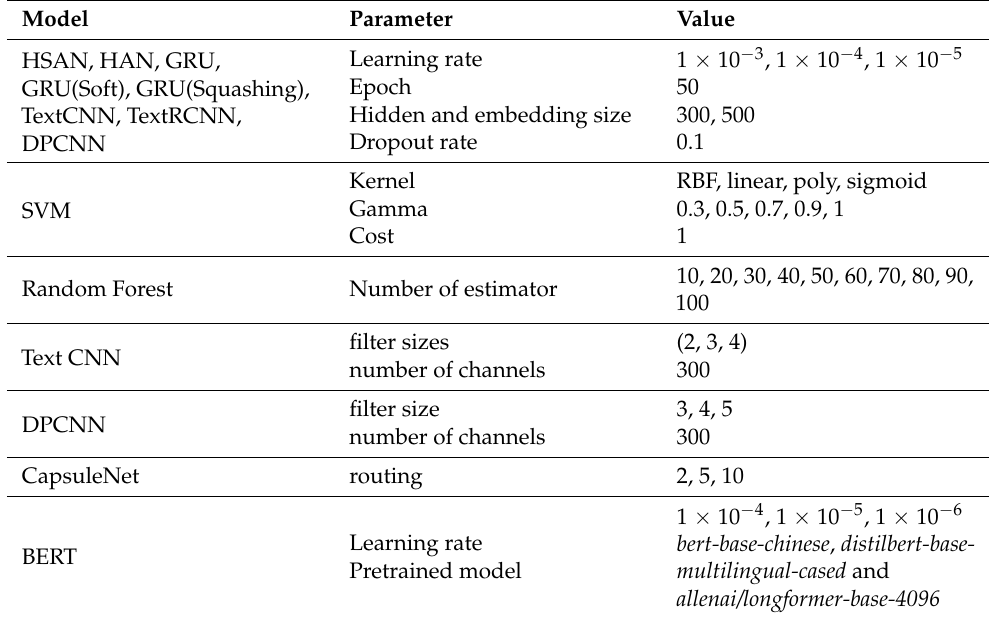
Table 5. Parameter settings of the compared